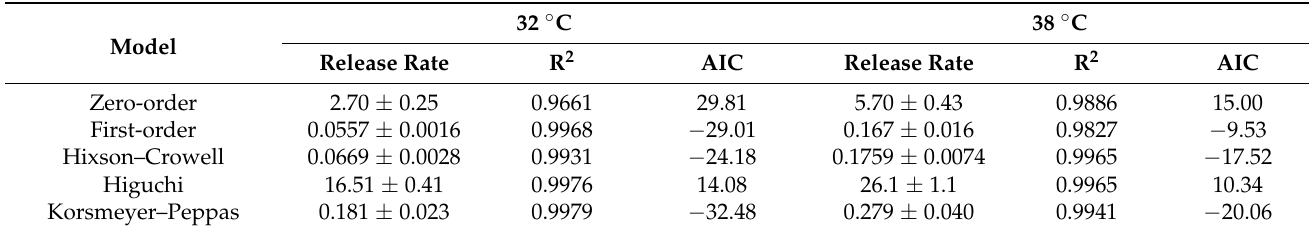
Table 3. Kinetic release models for F3 at 32 ◦ C during 24 h and at 38 ◦ C during 12